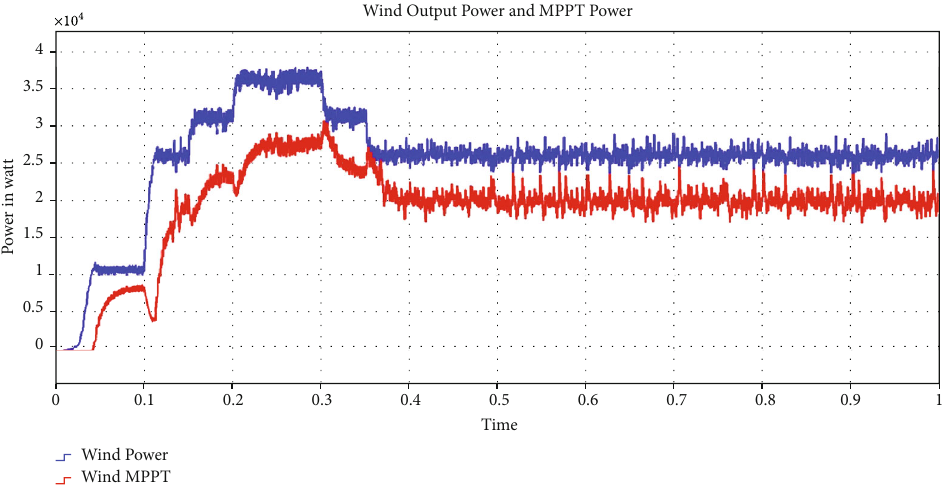
Figure 20: Comparative analysis with and without wind MPPT power (for di ff erent wind